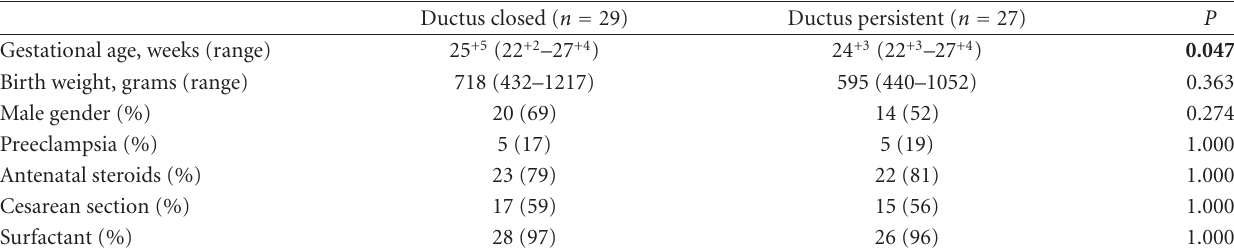
Table 1: Perinatal